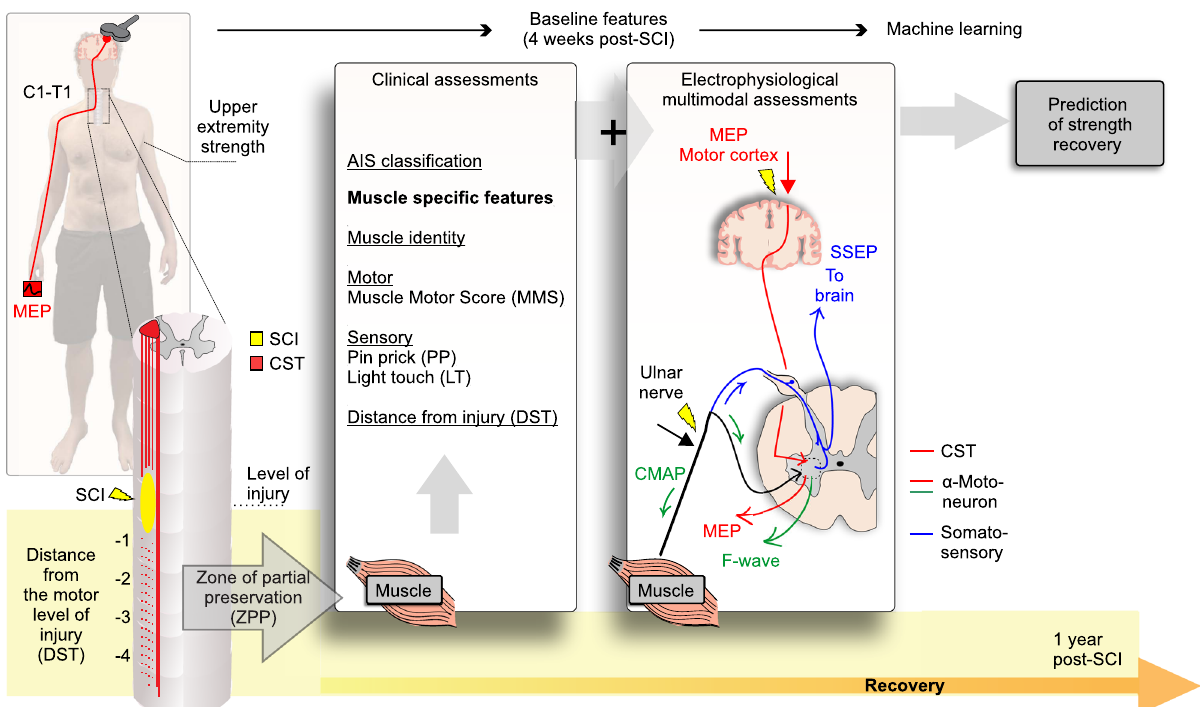
Fig.2|Anatomicalandinjurycharacteristicshypothesizedtobedeterminants ofsegmentalmusclerecovery. Muscleidentitymayplayaroleduetovariationsin cortical representation and CST projections. Remaining spinal innervation after injury may be re fl ected in the muscle motor score (MMS), sensory scores in cor- responding dermatomes (PP and LT), and electrophysiological assessments (MEP, SSEP). NCS may improve predictions by providing information about α - motoneuron damage. AIS grade and distance from injury further determine the